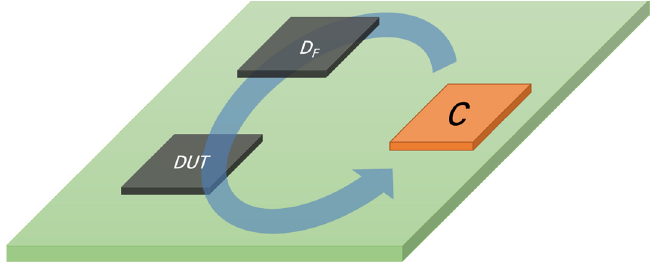
Figure 3. Single static power loop.